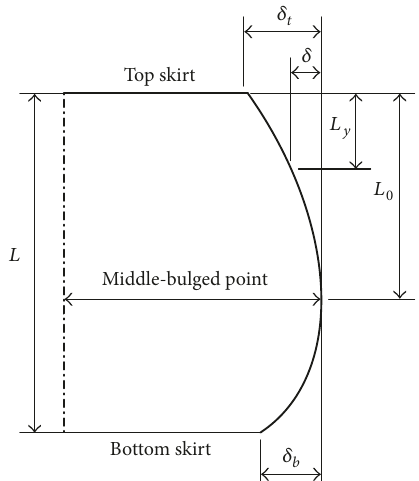
Figure 4: Longitudinal profile of piston